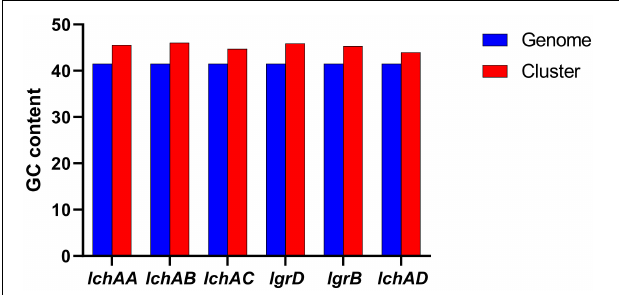
FIGURE 5 | Comparison of G + C contents of the lichenysin clusters with the B. altitudinis GLB197